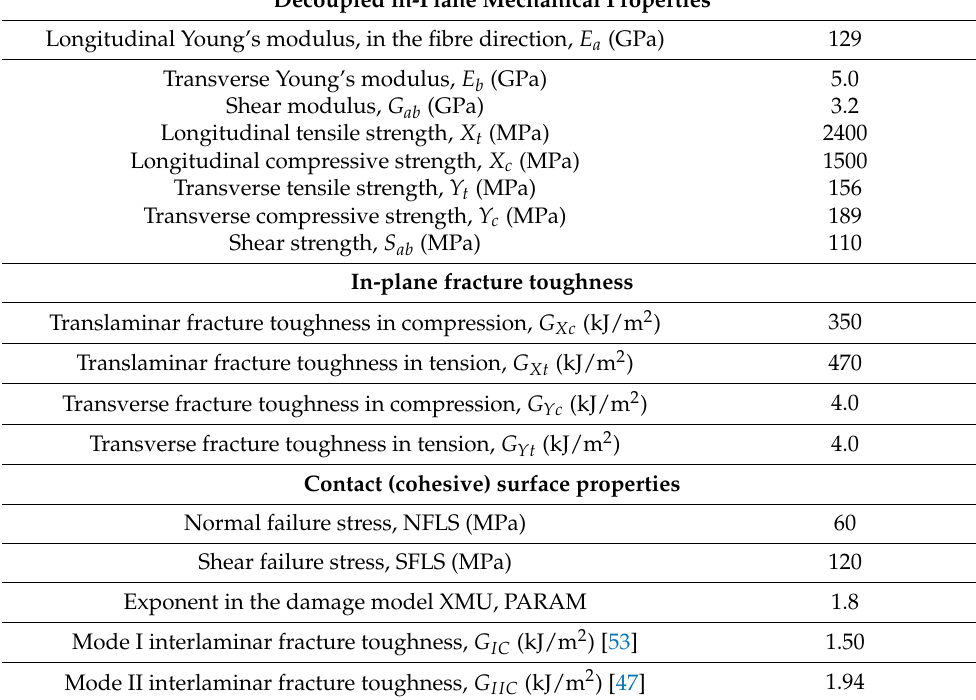
Table 5. Parameters used to describe the mechanical properties of the T700/PA6.6 CFRTP compos- ite [47,53] and the contact